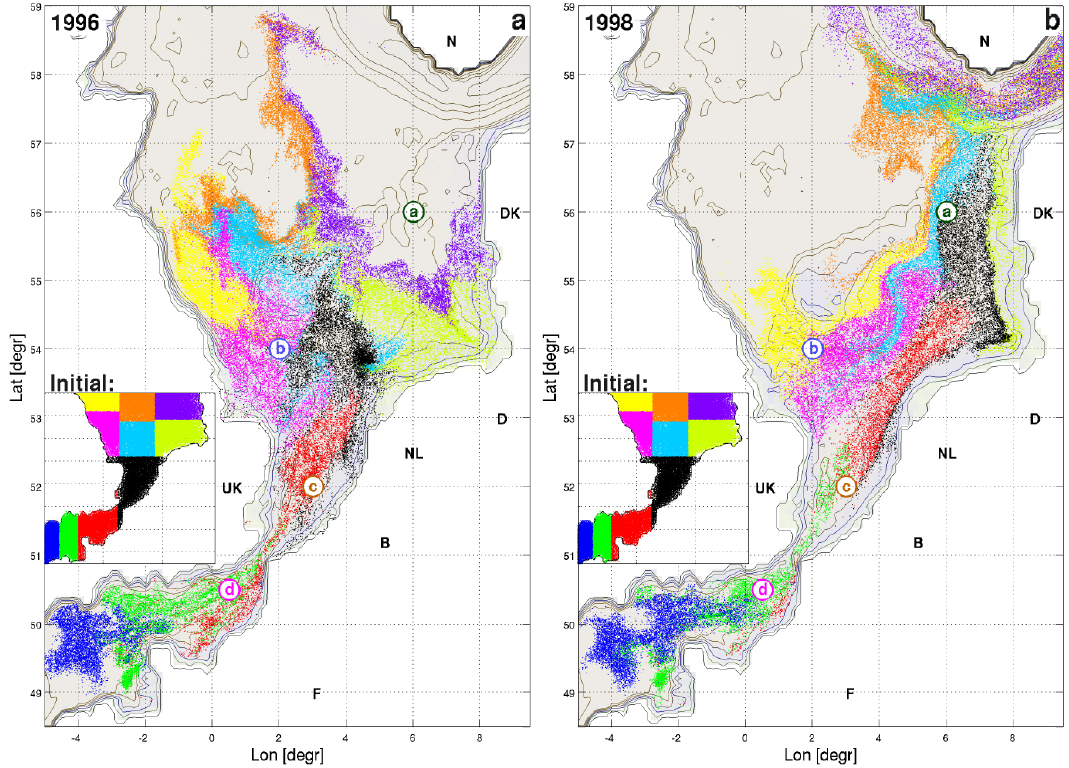
Figure 8. Distribution of particles at the end of their pelagic life span (up to 120 days) (a) 1996; (b) 1998. Only shown are particles that do not settle. Only 100000 particles that were released around 1 January are included. The colour of the dots corresponds to the release location of the particles, shown at the inset. Locations “a” to “d” correspond to data shown in Figs. 9 and 14. Table 1. Relationship between variability in forcing conditions and changes in settlement success. Settlement success is represented be the variability in the number of settling particles and by the number of particles with truncated development. The forcing conditions constitute the SST over February for each year at station d, and the percentages of wind intensity from the south-west at station d (the intensity is determined as the average wind speed from this direction times the percentage of time the wind is coming from this direction, this value is then divided over sum of intensities for all wind directions). CV stands for coefficient of variation (SD/mean × 100), SD for standard deviation, and Corr. for Correlation coefficient. Bold numbers indicate a high correlation. Mean SD CV (%) Corr. Temp Corr.